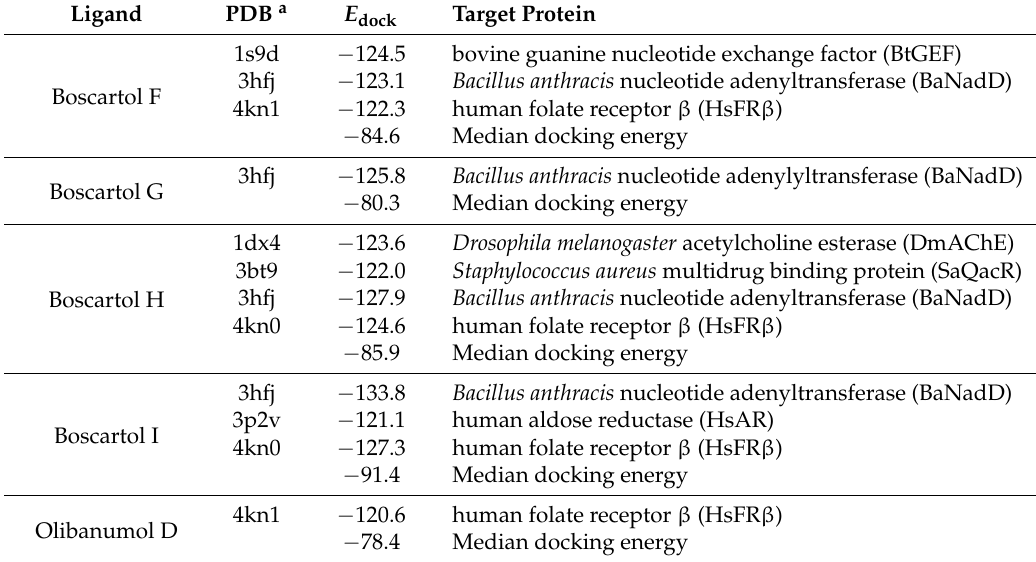
a PDB: Protein Data Bank code.